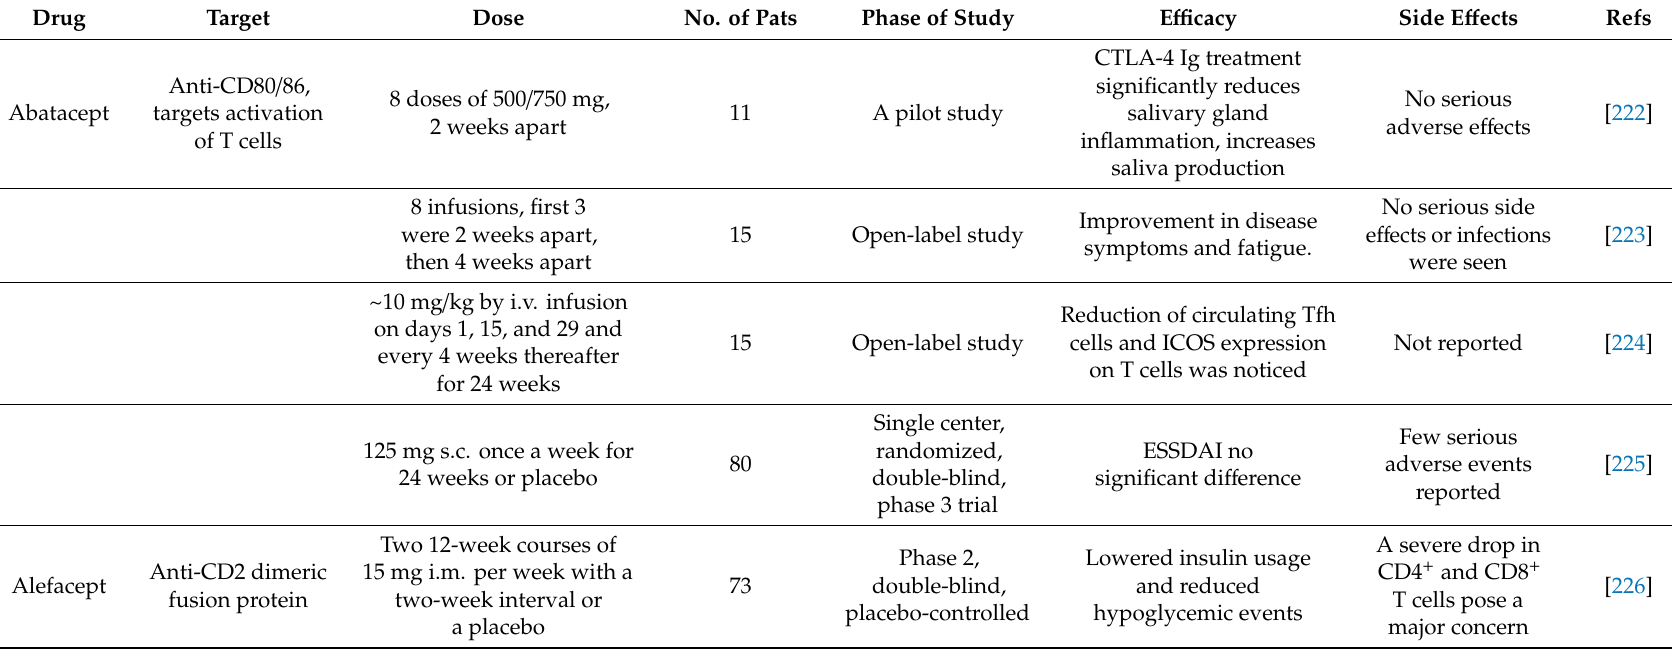
Table 2. T cell targeted therapies in pSS